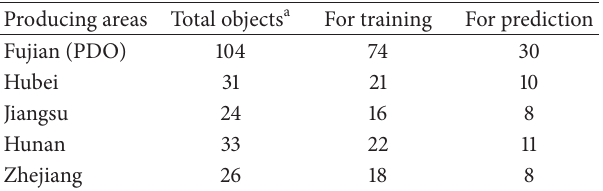
Table 2: Splitting of the data for training and